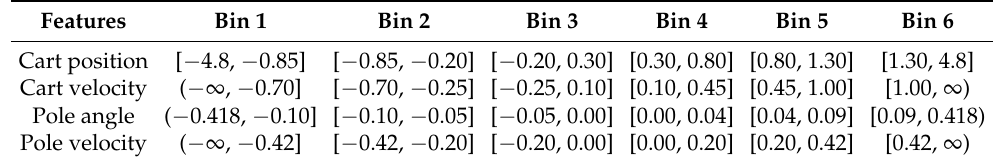
Table A3. Discretized values for each feature in the Cartpole environment: these intervals are obtained using the K-means clustering method with K =